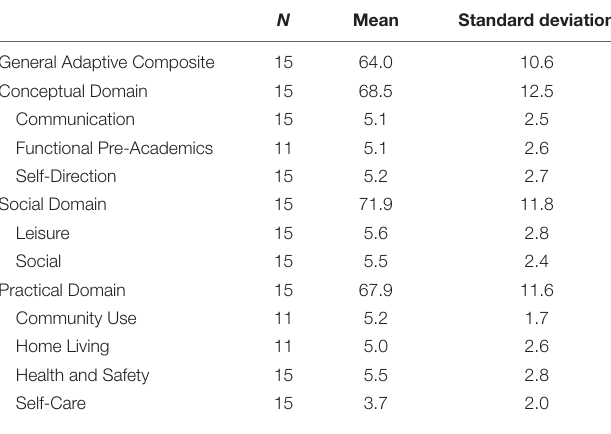
TABLE 2 | Mean Scores on the